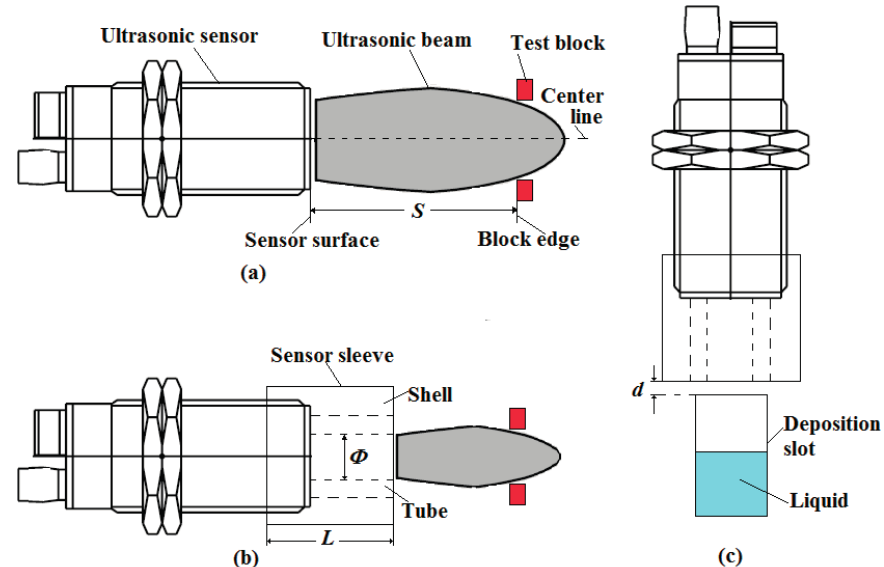
Figure 3. Beam diameter test of the ultrasonic sensor and schematic of deposition measuring. ( a ) Beam diameter test of the sensor without sleeve; ( b ) Beam diameter test of the sensor with sleeve; ( c ) Schematic of deposition measuring using the sensor with sleeve.